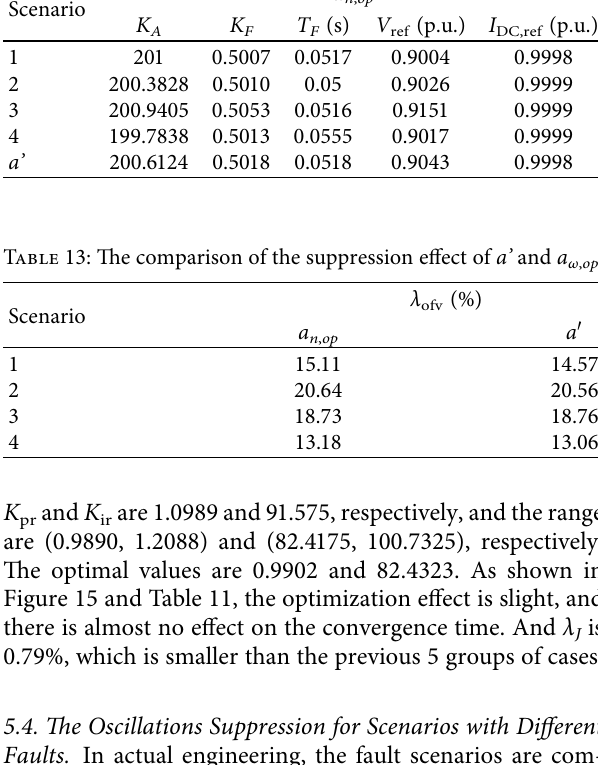
Table 12: Te optimization under scenarios with diferent faults. Scenario